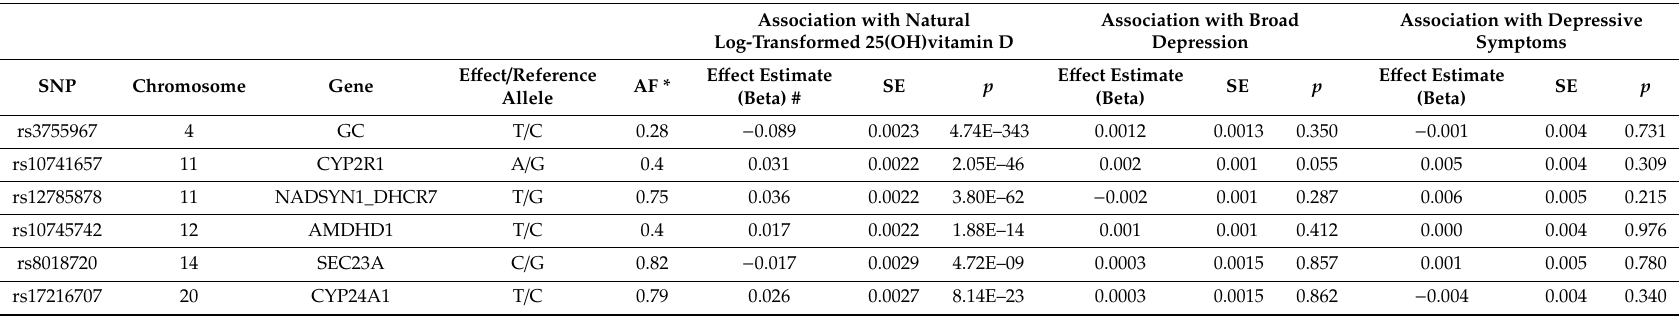
Table 1. Genome-wide significant single nucleotide polymorphisms (SNPs) for natural log-transformed 25(OH)vitamin D concentrations and their association with broad depression and depressive